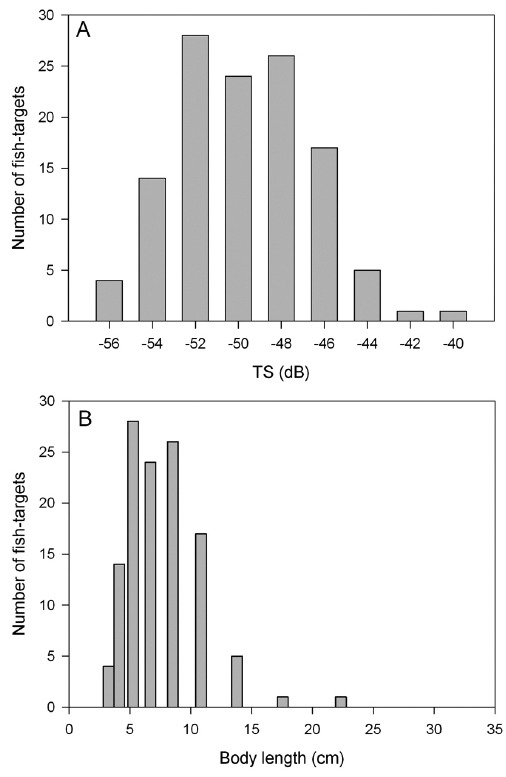
Figure 6. TS distribution (A) and body length distribui- tion in centimeters (B) of all echoes associated with fish acquired by echo-counting, Lagoa Santa, April 28,